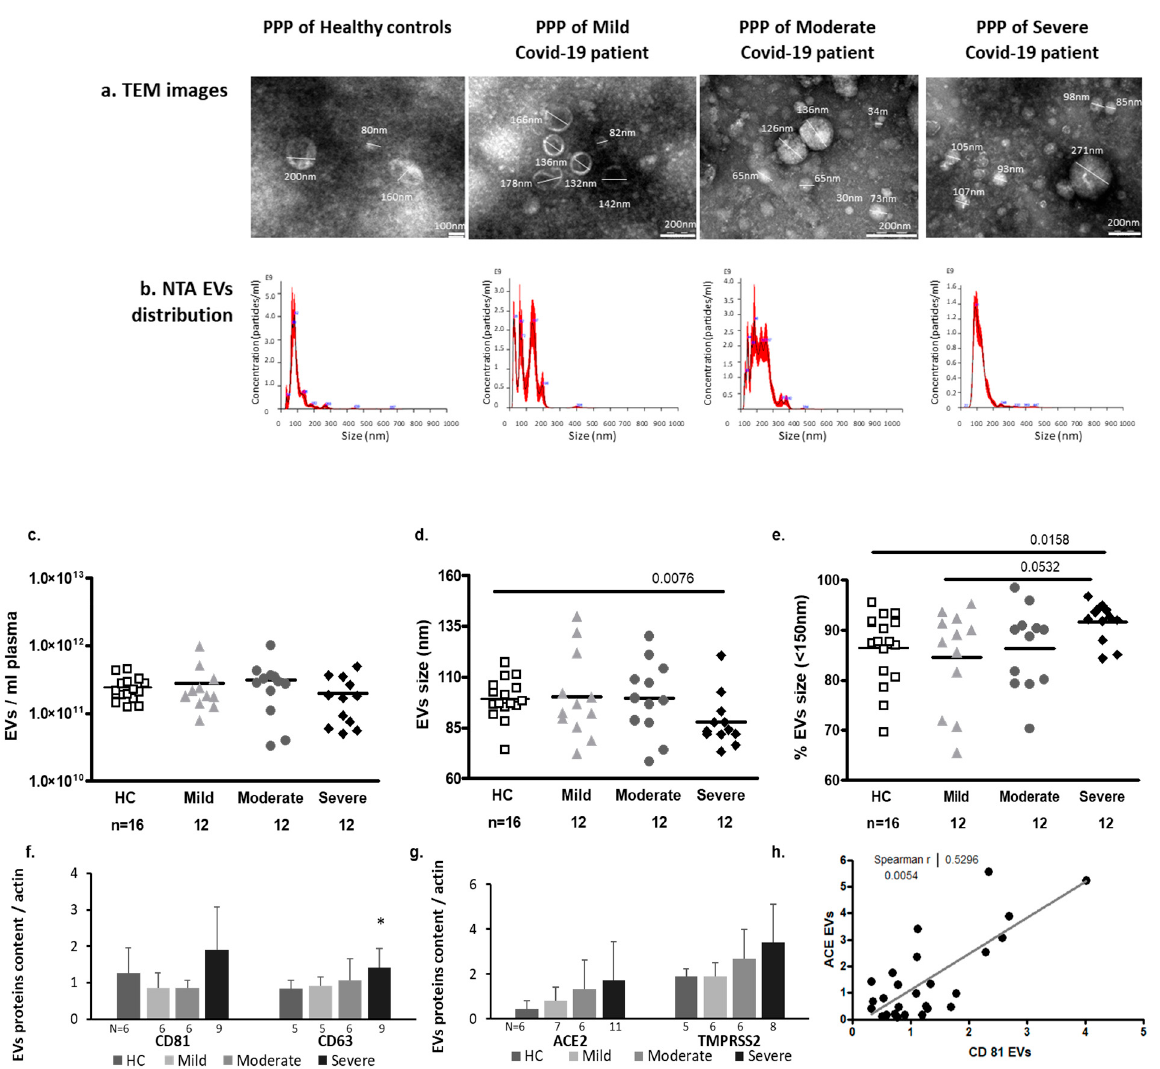
Figure 2. Extracellular vesicle (EV) concentration, size distribution, and expression of exosome markers and markers of viral entry proteins. Platelet-poor plasma (PPP) samples were obtained from the healthy controls and the three patient subgroups: mild, moderate, and severe. ( a ) Transmission electron microscopy (TEM) images of EVs obtained from the study cohorts. ( b ) PPP EV size distribution graph of a representative sample obtained from each of the study cohorts, measured by nanoparticle tracking analysis (NTA). ( c ) PPP EV concentration (particles/mL) and ( d ) mean size distributions were measured by NTA. The graph presents the percentage of small EVs (<150 nm) in each sample ( e ). N = the number of samples that were validated in each subgroup. The expression levels of exosome markers CD63, CD81 ( f ) and SARS-CoV-2 virus entry proteins angiotensin-converting enzyme 2 (ACE-2) and the cell surface transmembrane protease serine 2 (TMPRSS-2) ( g ) were determined by densitometry of a Western blot of samples isolated from the control group and the three COVID-19 subgroups. The graph presents the mean ± standard deviation of each protein expression as a ratio of actin in EV pellets. Gel images are presented in Supplementary Figure SM1. The correlation between the expression of ACE and CD81 is presented in ( h ), * p <